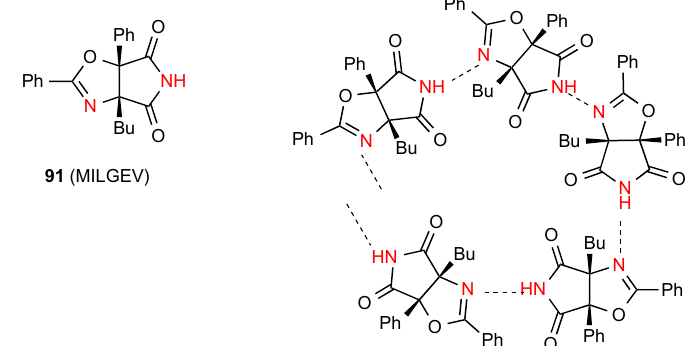
Figure 33. Structure adopted by compound 91.